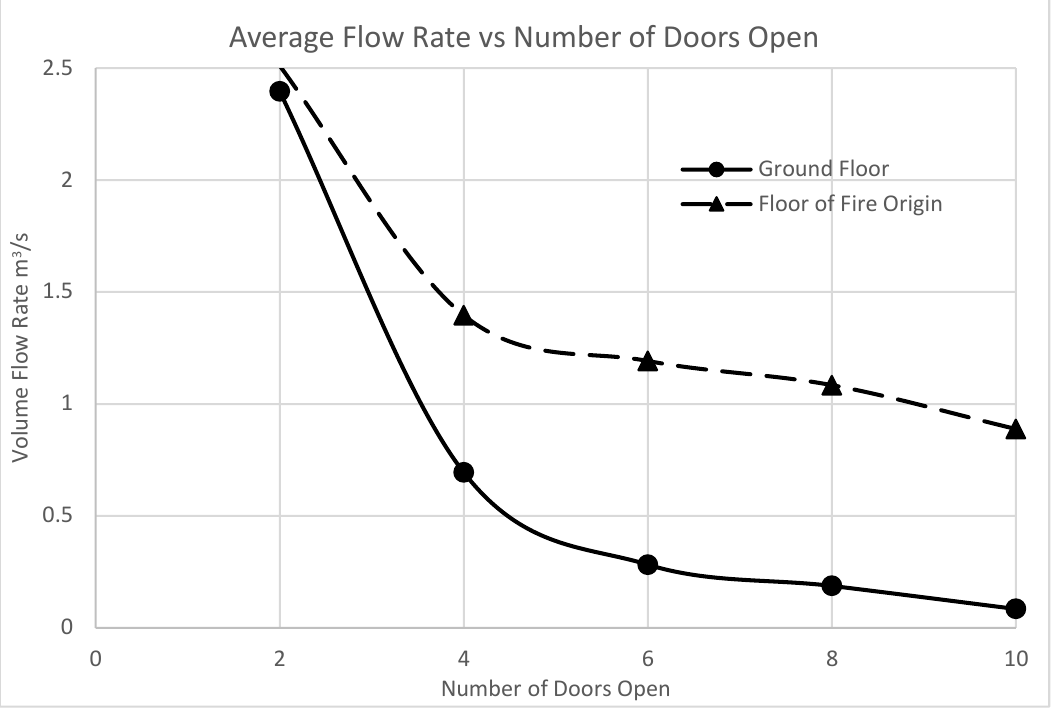
Figure 17. Flow rate through doors of interest as the number of doors open in the shaft increases.